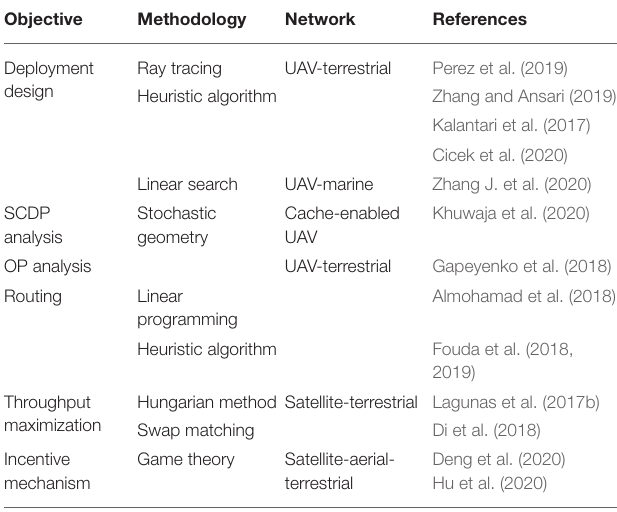
TABLE 6 | Taxonomy of literature in section